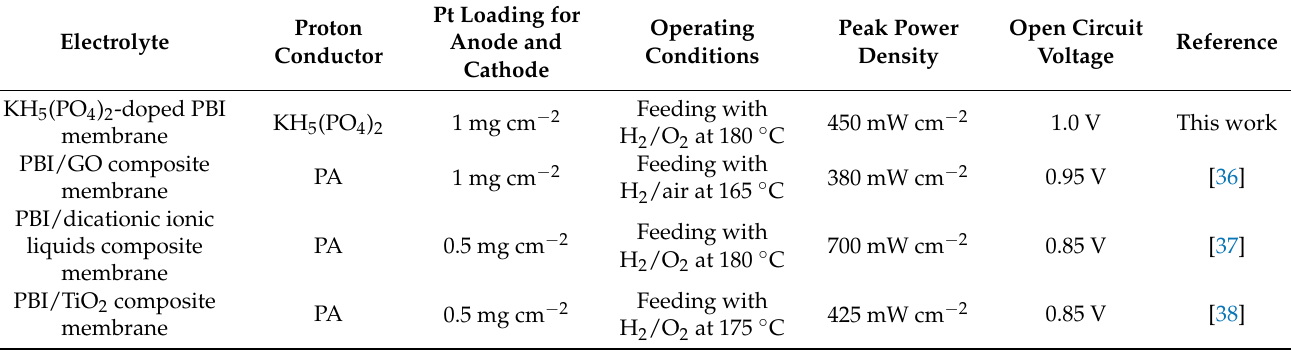
Table 1. Comparison of the performance of some PBI-based composite